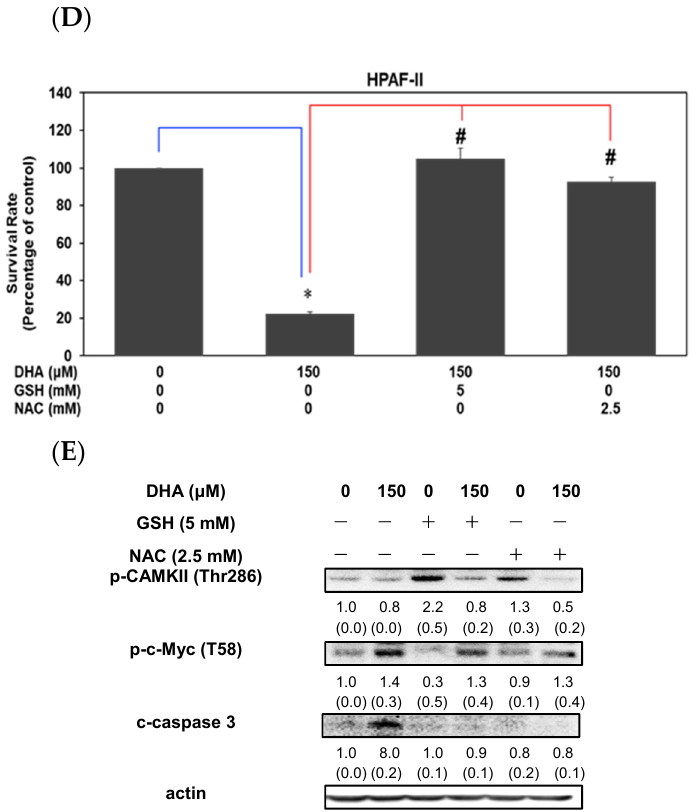
Figure 4. DHA induced cell death through an increment of GSSG/GSH ratio and reactive oxygen species level in HPAF-II cells. Human PDAC HPAF-II cells were treated with DHA at different concentrations in 10% FBS DMEM for 24 hr. ( A ) Cellular levels of GSSG and GSH were measured by using LC- MS system as described in Material and Methods Section. ( B ) Cellular levels of ROS were measured using flow cytometry, according to the previous methods described in the Material and Methods Section. Human PDAC HPAF-II cells were treated with DHA in the presence or absence of GSH or NAC in 10% FBS DMEM for 24 hr. ( C ) Cellular levels of free radicals were measured according to previous methods. ( D ) Cell survival was analyzed using MTT assay as described in the Materials and Methods Section. Statistical significance is expressed as the mean ± SD of three independent experiments. An asterisk (*) represents statistically significant differences in comparison with the control subgroup ( p < 0.05). A pound (#) sign represents statistically significant differences in comparison with the DHA (150 μ M)-treated subgroup ( p < 0.05). ( E ) Human PDAC HPAF-II cells were treated with DHA in the presence or absence of GSH or NAC in 10% FBS DMEM for 24 hr. Western blotting analysis of cytoplasmic proteins (at 24 hr time point) was performed using antibodies against p-CAMKII (T286), p-c-Myc (T58), cleaved-caspase 3 (c-caspase3) and actin. Band intensities represent as the mean ± SD (within parenthesis) for the amount of each protein in comparison with actin.